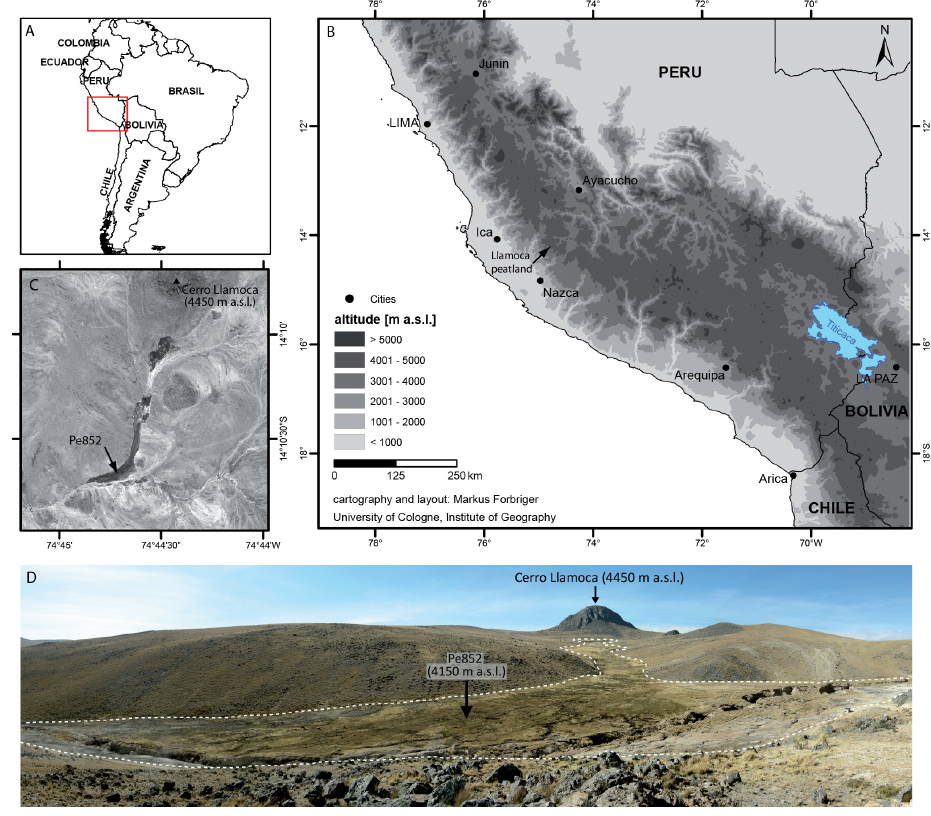
Figure 1. (a) Map of Peru and adjacent countries (data source: GLCF World Data). (b) The location of Cerro Llamoca peatland (CLP) in the western Andes of southern Peru (data source: DGM-GTOPO 30). (c) Aerial photograph of CLP with Cerro Llamoca in the north and location of the coring site of core Pe852 (Servicio Aerofotográfico Nacional – SAN, Lima). (d) Panorama of CLP with the name-giving peak and the location of the coring site. Dashed lines indicate the extension of the peat- and sediment-accumulating area. The southern part of the peatland is separated from water supply by a deeply incised